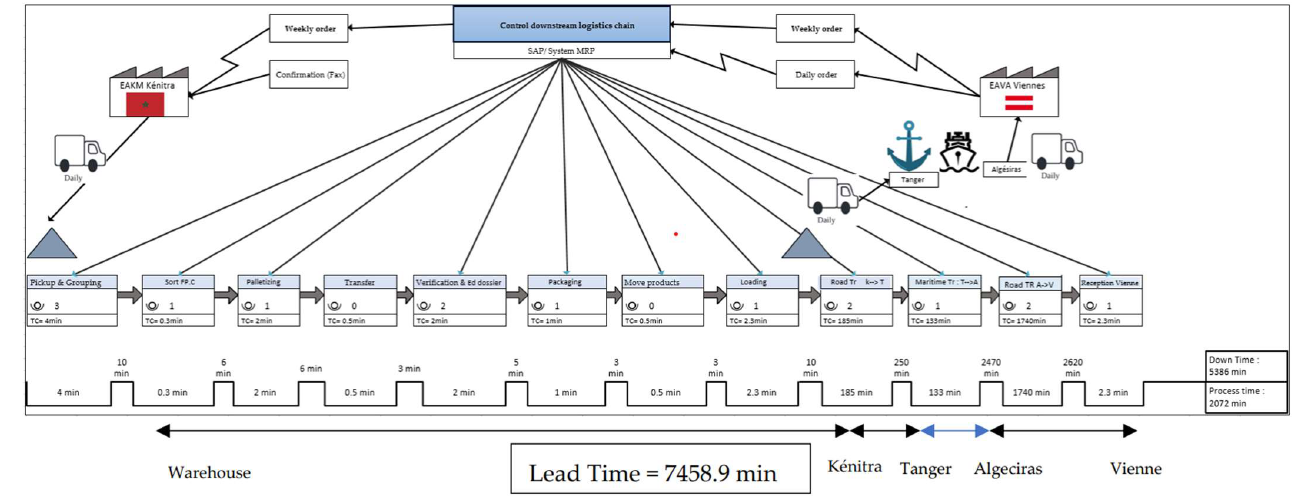
Figure 7. Future State 4.0 Mapping.